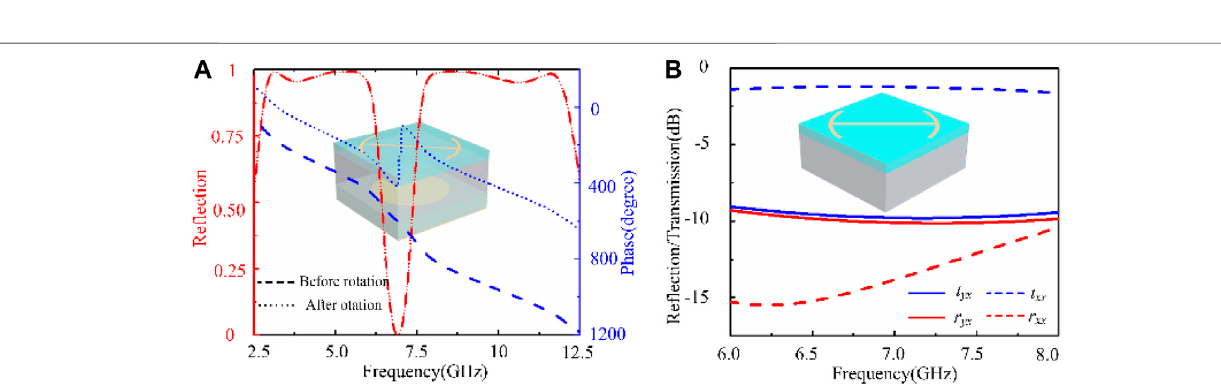
the biarc unit. The metal patterns are etched on the F4B ( ε r (cid:1) 2.65, the loss tangent of 0.001). The patterned slabs are pasted on